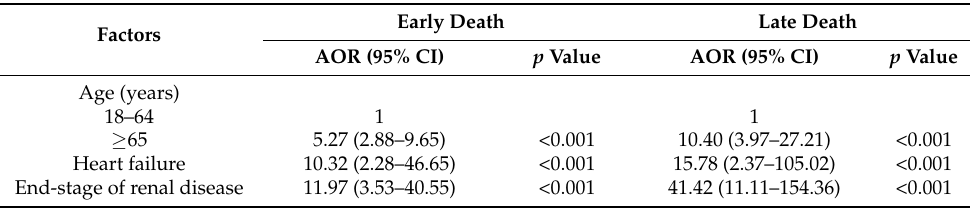
Table 3. Multinomial regression analyses of risk factors for early and late death in patients with COVID-19 #